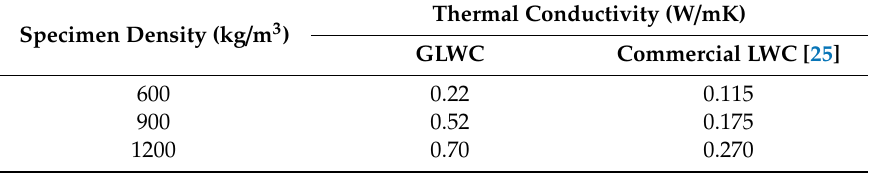
Thermal conductivity values of GLWC and commercial cement-based lightweight concrete